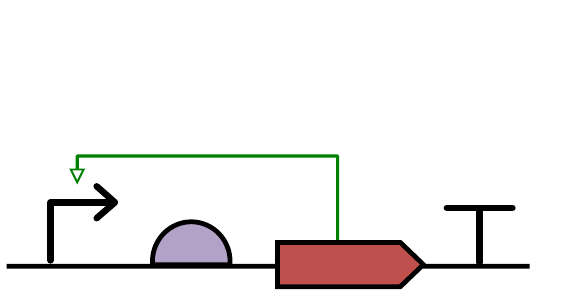
Figure 16: Example of an interaction indicating a promoter stimulated by the CDS that it regulates.